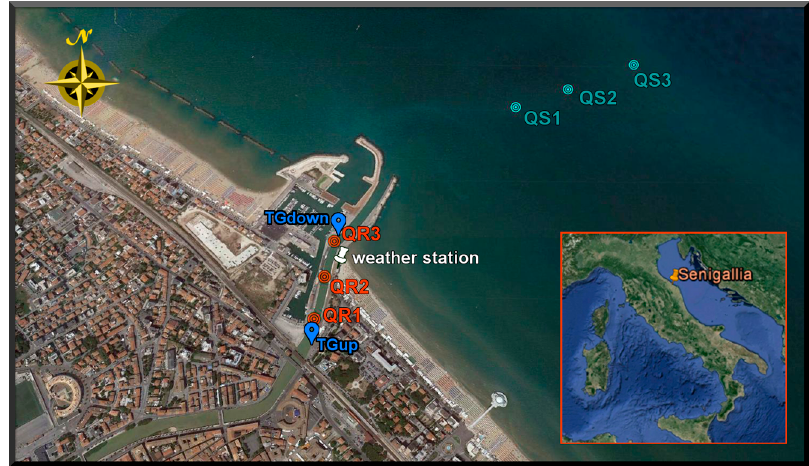
Figure 1. The Misa River estuary in Senigallia (Italy) depicting locations of measuring stations within the final river reach (TGdown, QR1, QR2, QR3, TGup) and in the sea (QS1, QS2,